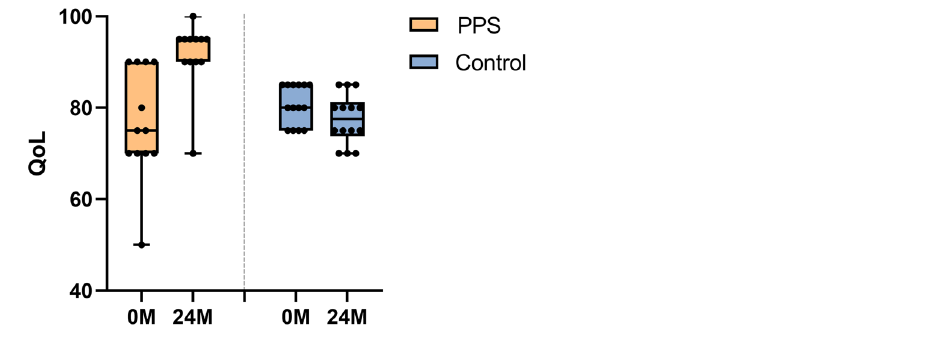
Figure 3. Changes in quality of life score between 0 M (before trial) and 24 M (2 years after trial initiation) in each group. Group mean is shown with a line, and whiskers represent the min to